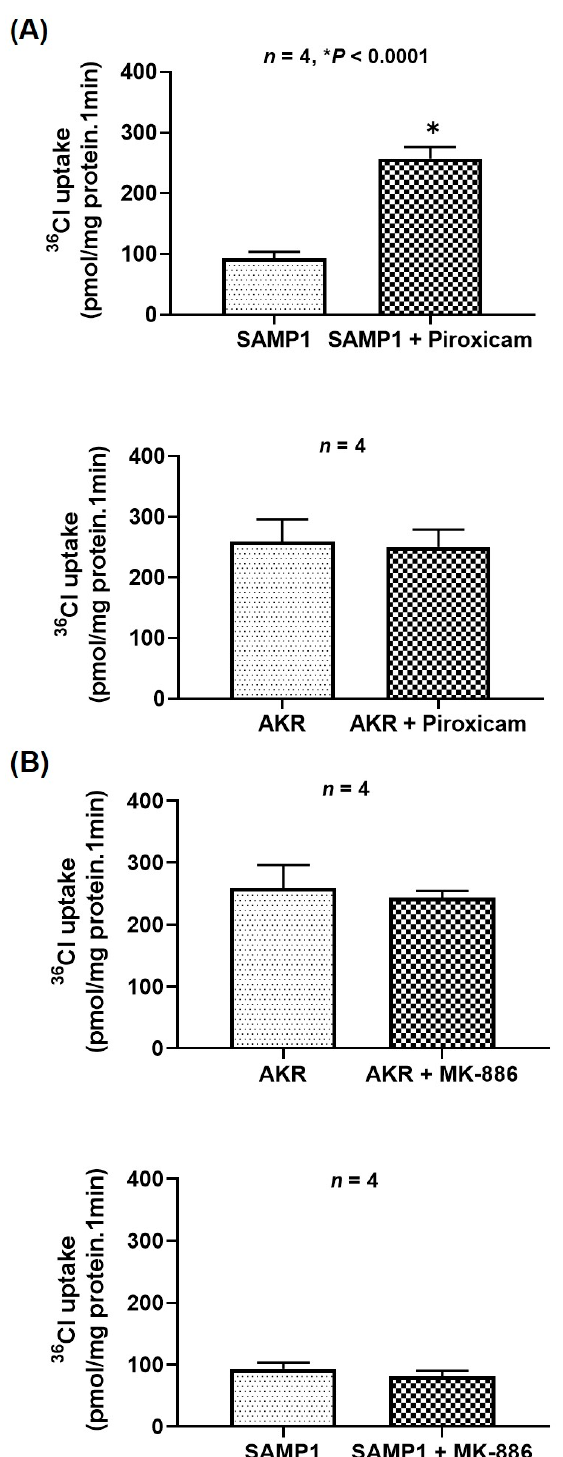
Figure 4. Effect of ( A ) piroxicam or ( B ) MK-886 treatment on Cl − /HCO 3 − exchange activity in SAMP1 mice. Mice were treated intraperitoneally for 2 days with piroxicam (10 mg/kg) or MK-886 (0.5 mg/kg) to inhibit COX or LOX pathways of AAM formation, respectively, and then, Cl − /HCO 3 − exchange activities were measured in BBMVs. ( A ) Piroxicam treatment significantly stimulated Cl − /HCO 3 − exchange in SAMP1 mice (upper panel) ( n = 4, * p < 0.0001), but had no effect in AKR mice (lower panel). ( B ) MK-886, while showing no effect on Cl − /HCO 3 − exchange in AKR mice (upper panel), did not block the inhibition of Cl − /HCO 3 − exchange in SAMP1 mice (lower panel). 2.5. Kinetic Analysis of AAM-Mediated Inhibition of Cl − /HCO 3 − Exchange in SAMP1 Mice